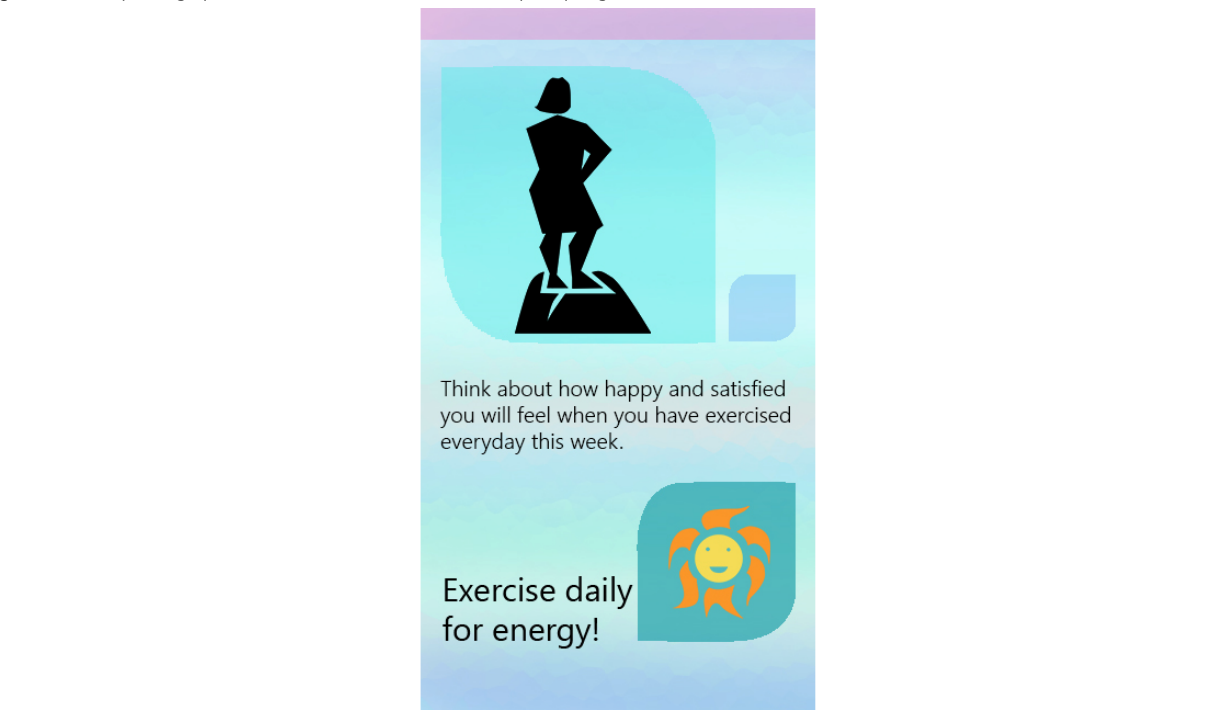
Figure 4. Example of graphic user interfaces of interventions (prompting to exercise).